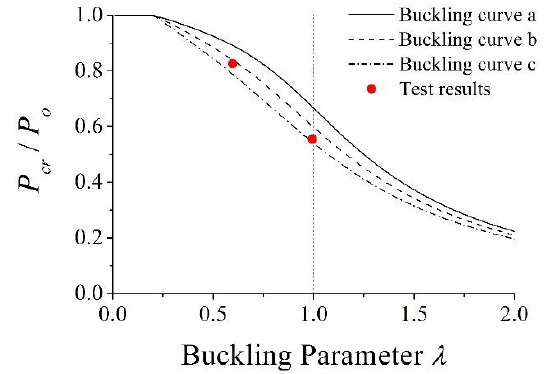
Figure 19. Comparison of the buckling curve from EC3 with test results.